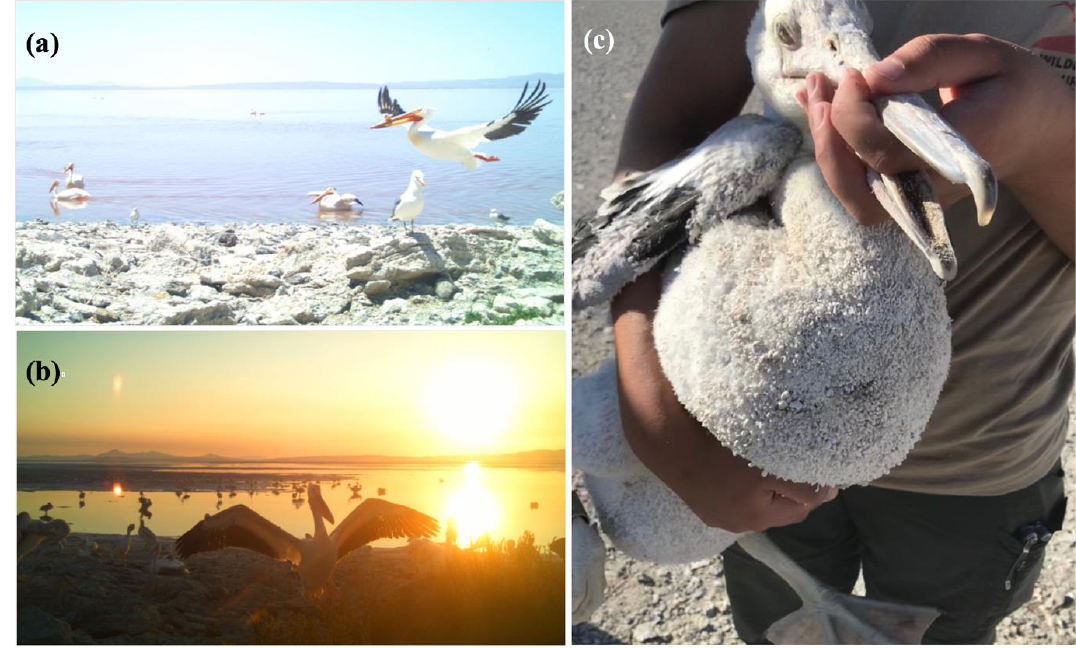
Figure 2. Gunnison Island American White Pelicans (AWPE). ( a ) and ( b ) Images from a motion- activated trail camera showing AWPE in contact with Great Salt Lake north arm hypersaline